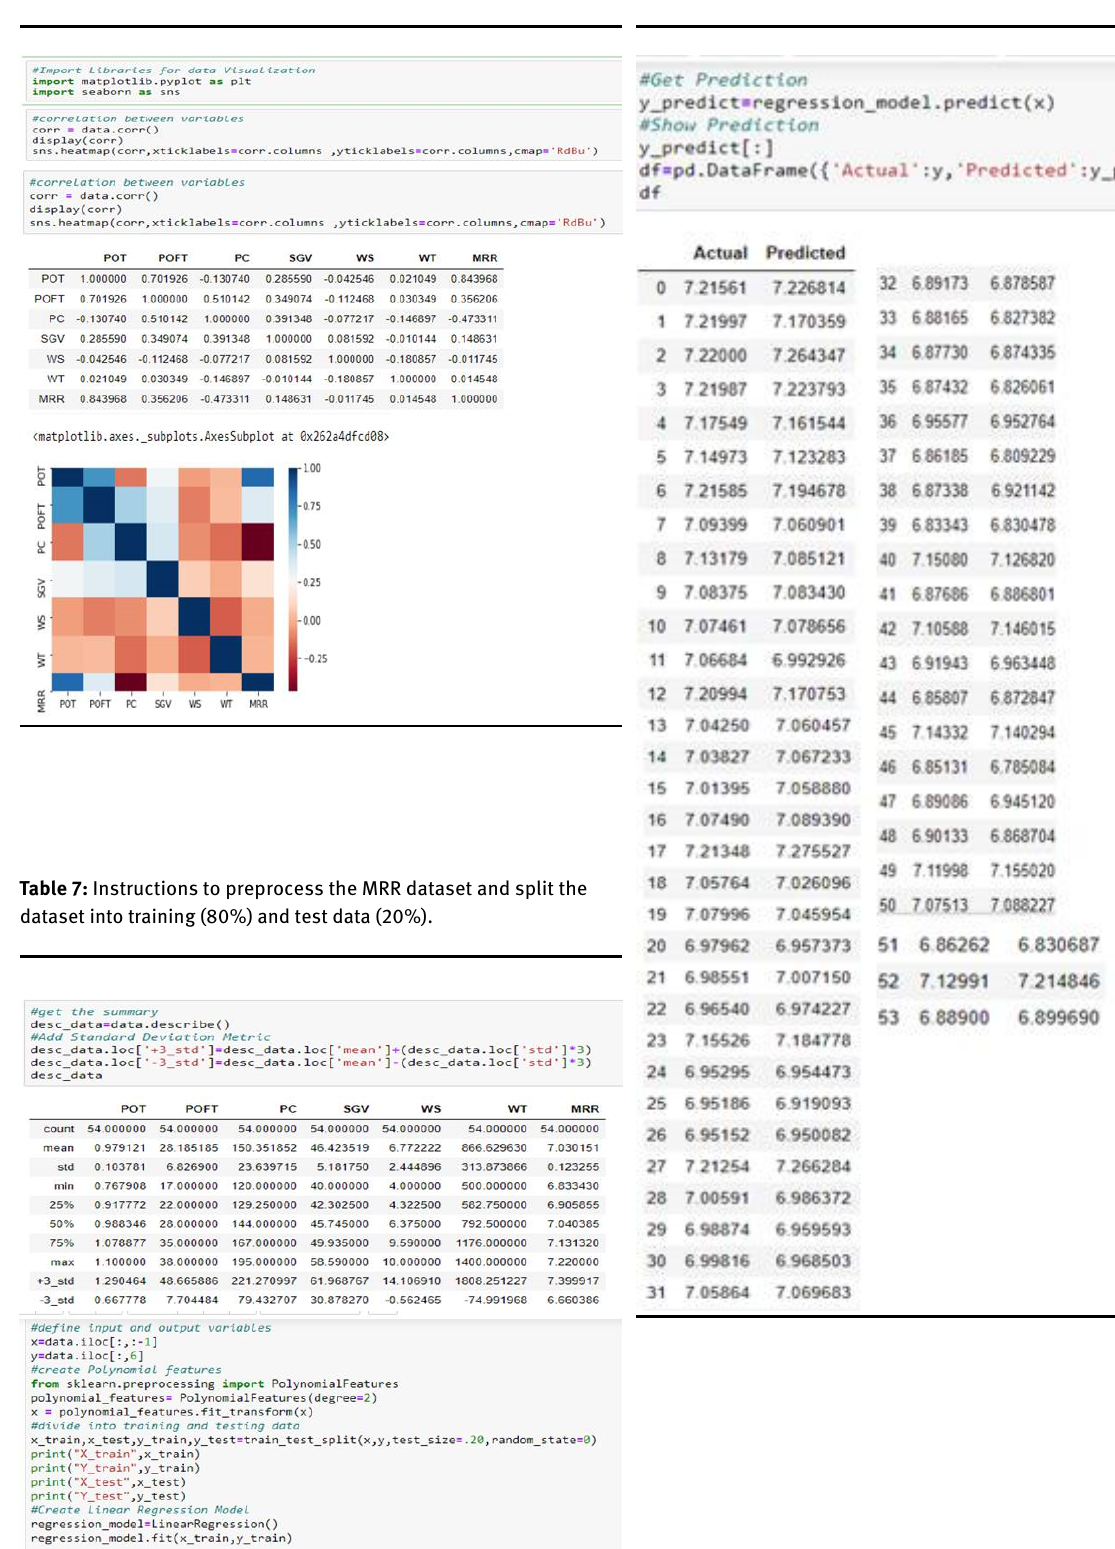
Table 8: Instruction to predict the data for MRR using trained